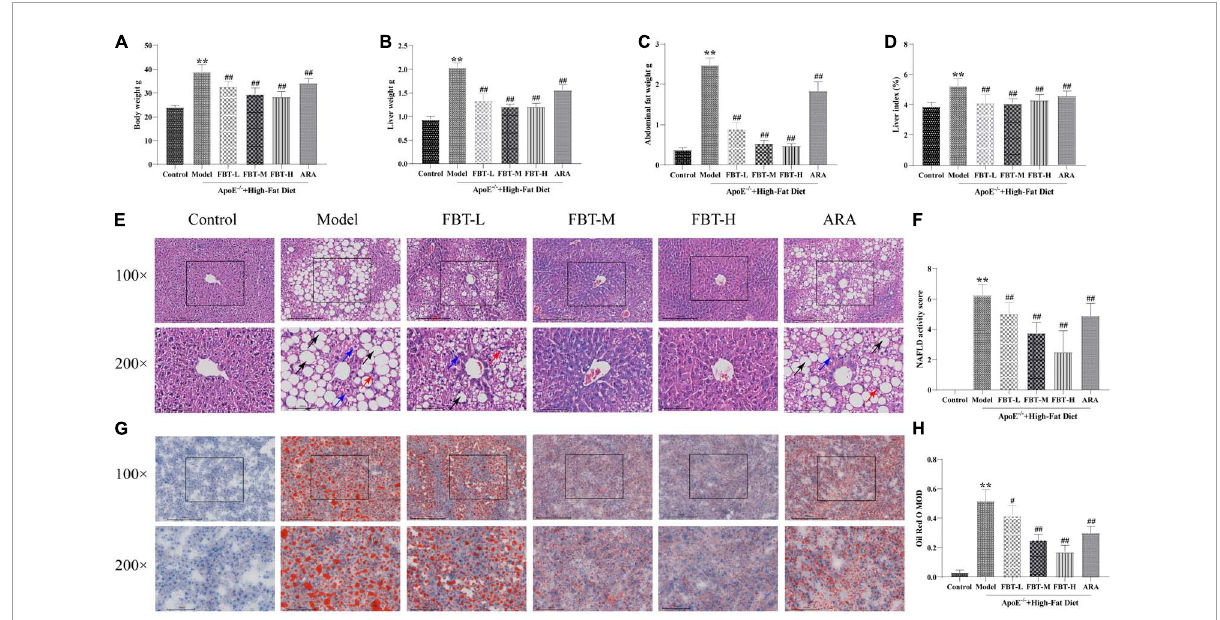
FIGURE2 Effects of fu brick tea (FBT) on body weight, liver weight, abdominal fat, histopathological morphology, and lipid deposition of NAFLD mice. (A) Body weight was reduced in NAFLD mice after treatment with FBT; (B) liver weight was reduced in NAFLD mice after treatment with FBT; (C) abdominal fat was reduced in NAFLD mice after treatment with FBT; (D) FBT treatment decreased the liver index in NAFLD mice; (E) HE staining indicated that FBT treatment ameliorated liver steatosis in NAFLD mice (100 × and 200 × ). Black arrows indicate the steatosis of hepatocytes, blue arrows indicate cytoplasmic rarefaction, and red arrows indicate lobular inflammation; (F) FBT treatment decreased the NAS score in NAFLD mice; (G) oil red O staining showed that FBT treatment improved the lipid accumulation in the liver; (H) the liver lipid contents were decreased in NAFLD mice after FBT treatment. N = 12. ** P < 0.01 vs. control group. # P < 0.05, ## p < 0.01 vs. model